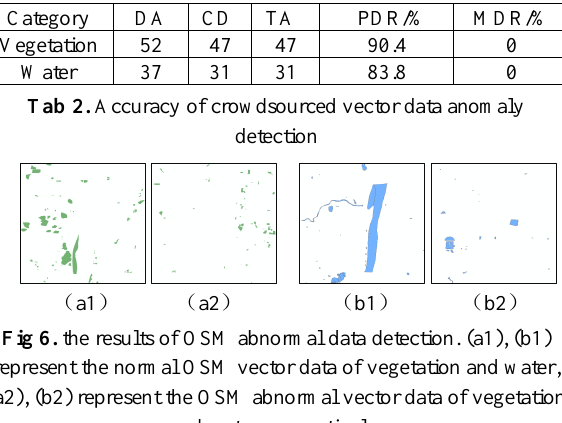
Fig 8. the problem of remote